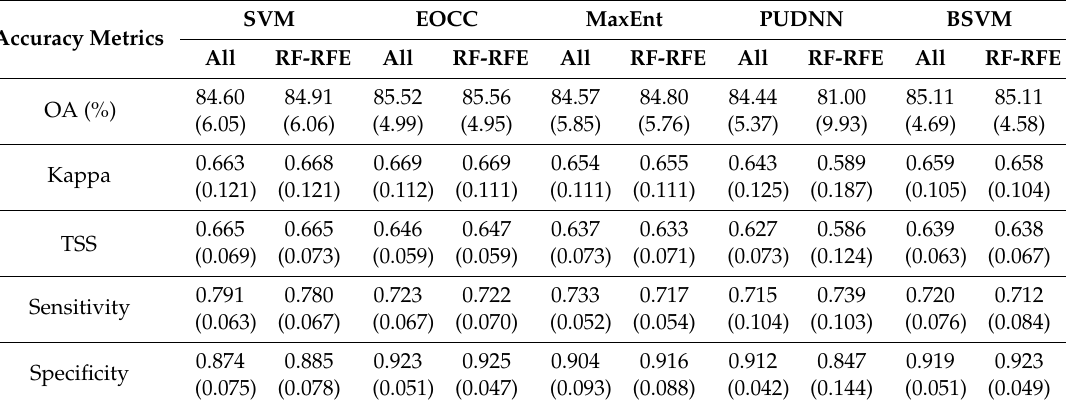
Table 3. Classification accuracies of the support vector machine (SVM) and one-class classifier (OCC) methods, using twelve variables and the optimal variables subsets selected by the random forest recursive feature elimination (RF-RFE) algorithm in Scenario 1. Values in parentheses are standard deviations. OA, overall accuracy; EOCC, ensemble OCC; MaxEnt, maximum entropy; PUDNN, positive